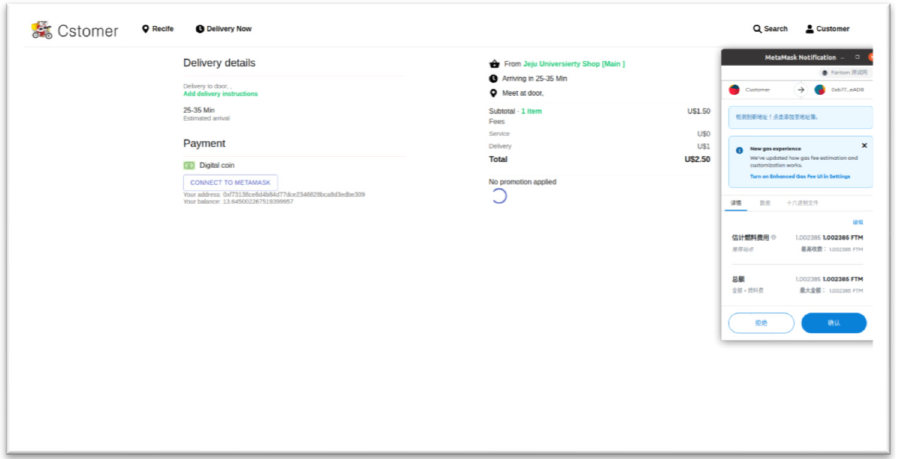
Figure 41. Client demo part in DAPP (Payment order).